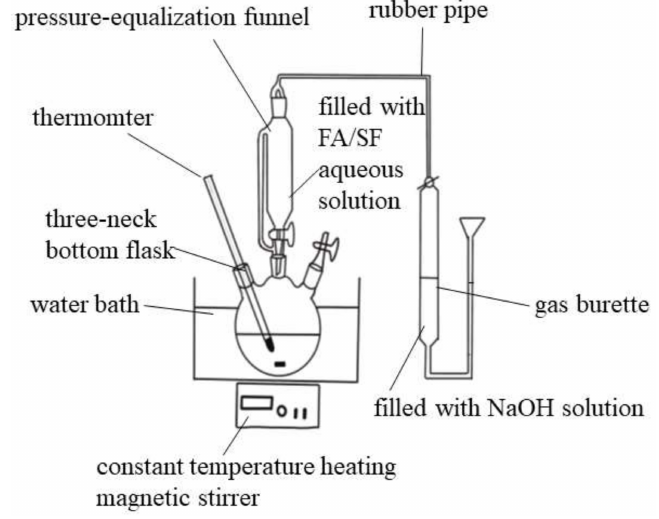
Figure 1. The device for evaluating the performances of catalysts in DFA.